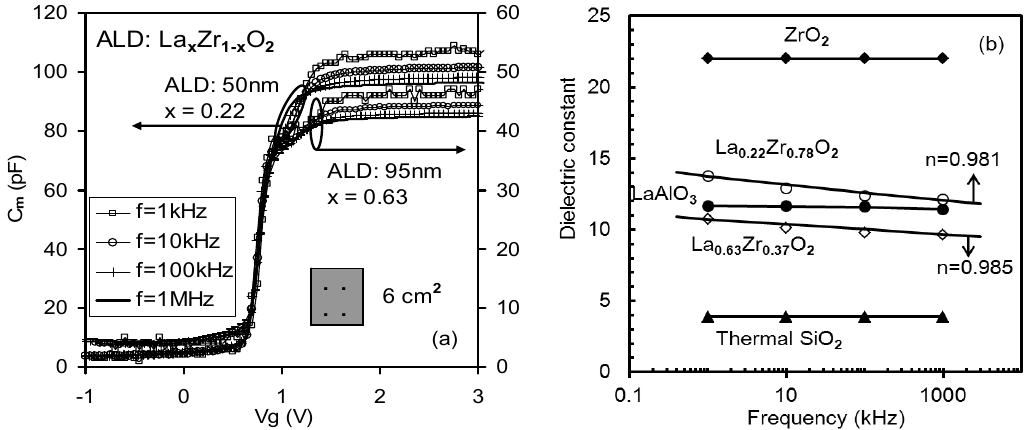
Figure 14. ( a ) Frequency dispersion in C-V measurements observed from La samples after back Al contact deposition and the effective substrate area was 6 cm 2 .